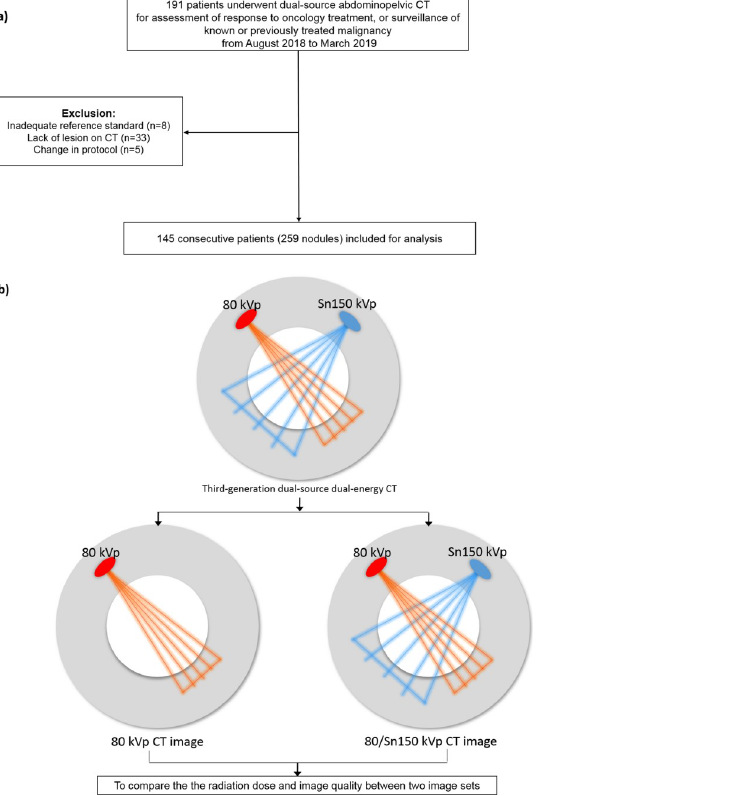
Fig 1. Patient flow chart. Selection process (a) and study design (b).